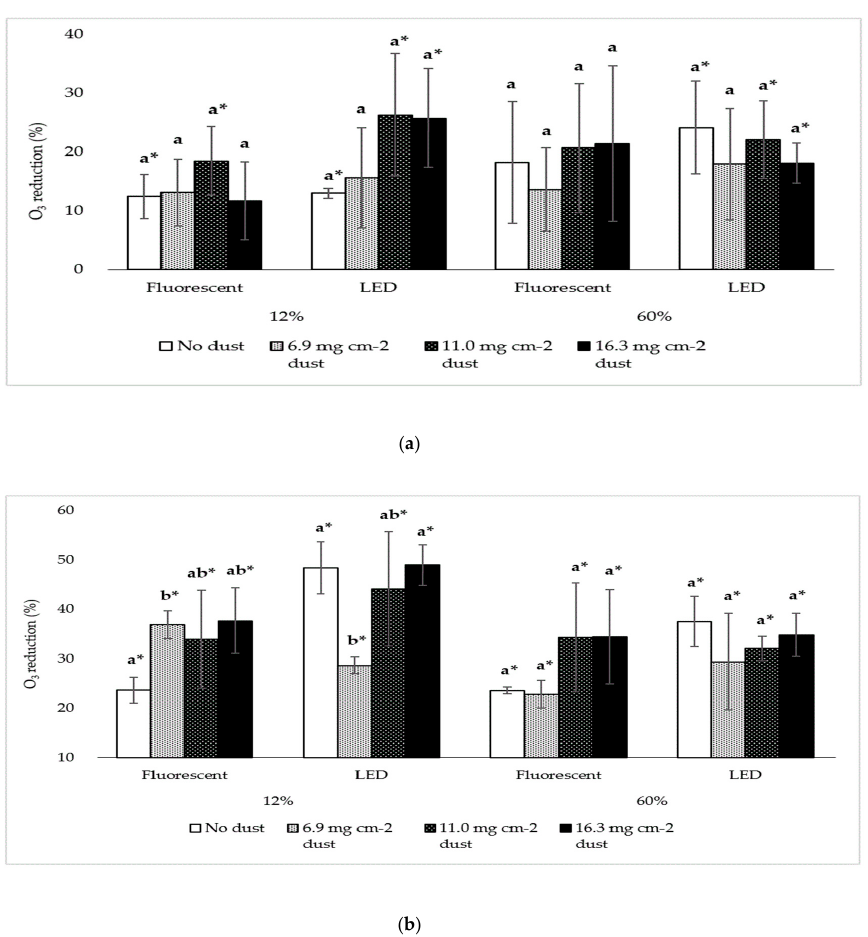
Figure 17. Comparison of O 3 mitigation under different poultry dust levels. ( a ) % reduction at a relative humidity of 12% and 60% in direct photolysis; ( b ) % reduction at a relative humidity of 12% and 60% in photocatalysis. Superscript (*) signifies a statistical difference compared to the control ( p < 0.05), and the different characters (a, b) signify the statistical difference between treatments associated with one UV lamp type and one relative humidity ( p < 0.05). Error bars signify ± standard deviation.